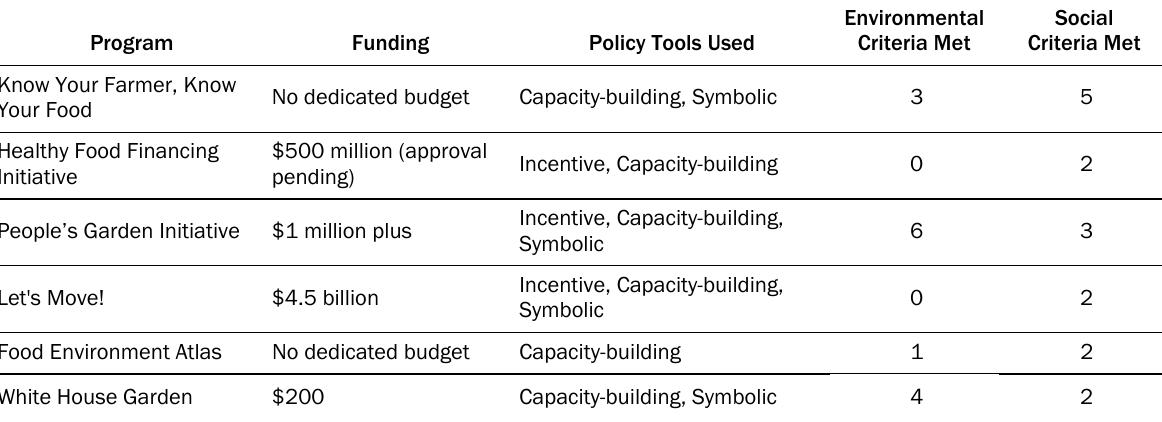
Table 3. Funding, Policy Tools, and Criteria for Programs and